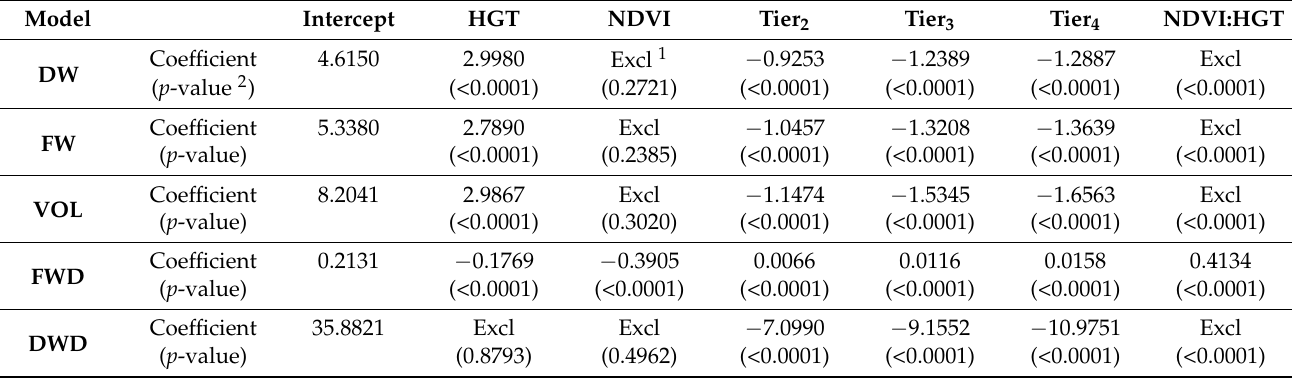
Table 3. Final UAS-based productivity models: coefficients and term